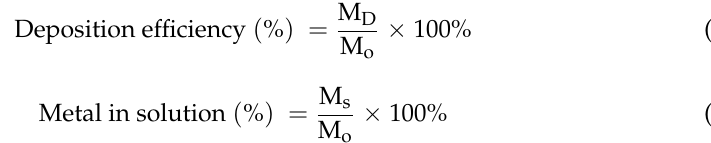
Table 1. Chemical compositions of the copper sludge sample.